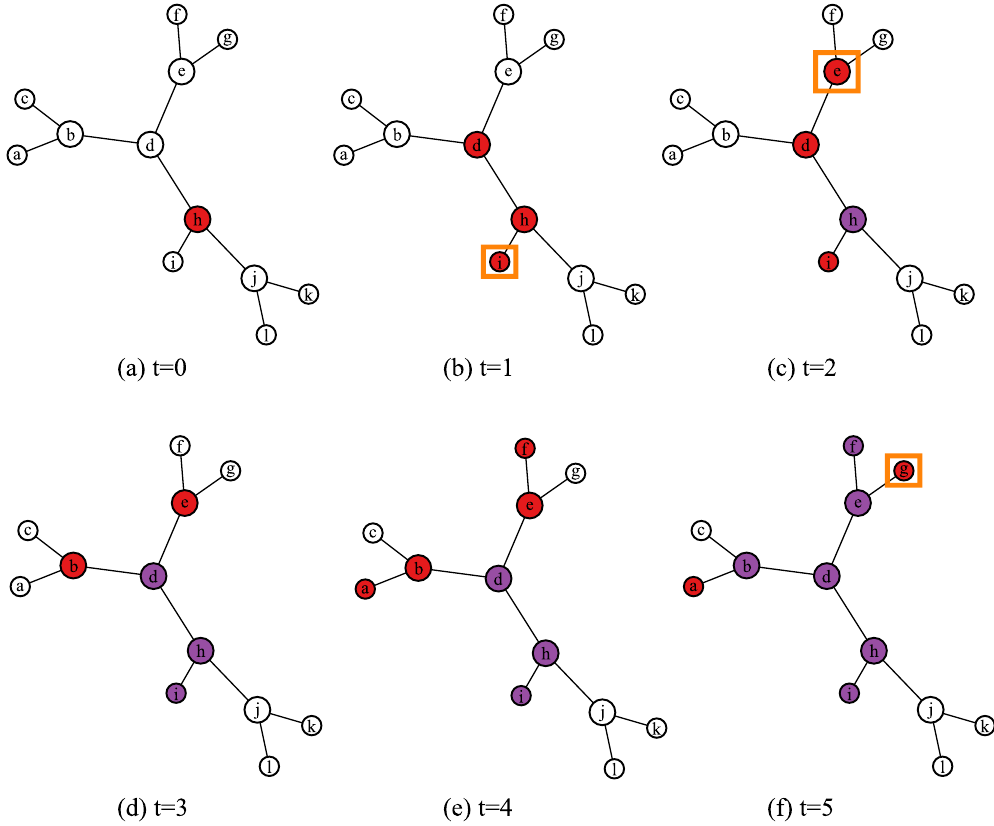
Figure 1. Schematic diagram of SIR spread process in a tree network. The time delay of each node all equals 1. ( a – f ) respectively represent the states of all nodes in network at six successive moments, among which white represents susceptible, red represents infectious, and purple represents recovered.